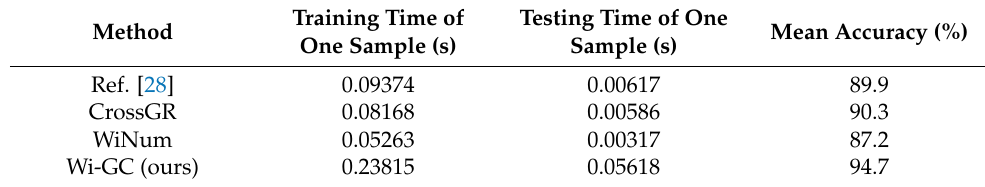
Table 2. Analysis of method